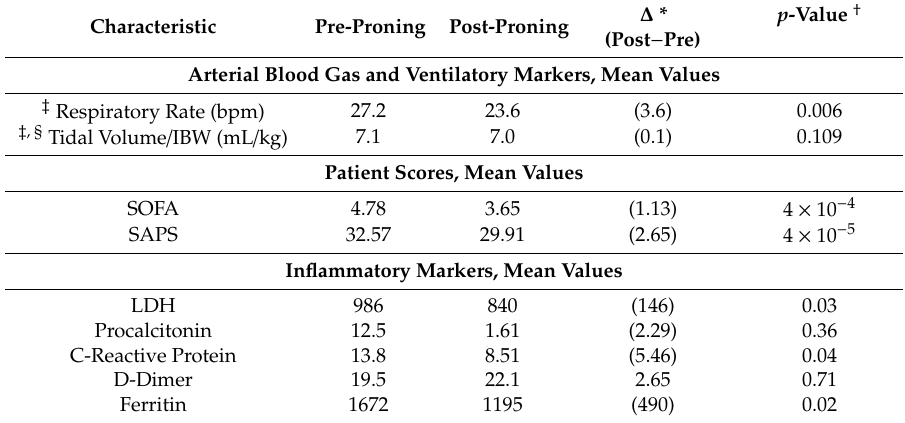
Table 2. Change in clinical measures and outcomes immediately post-proning.